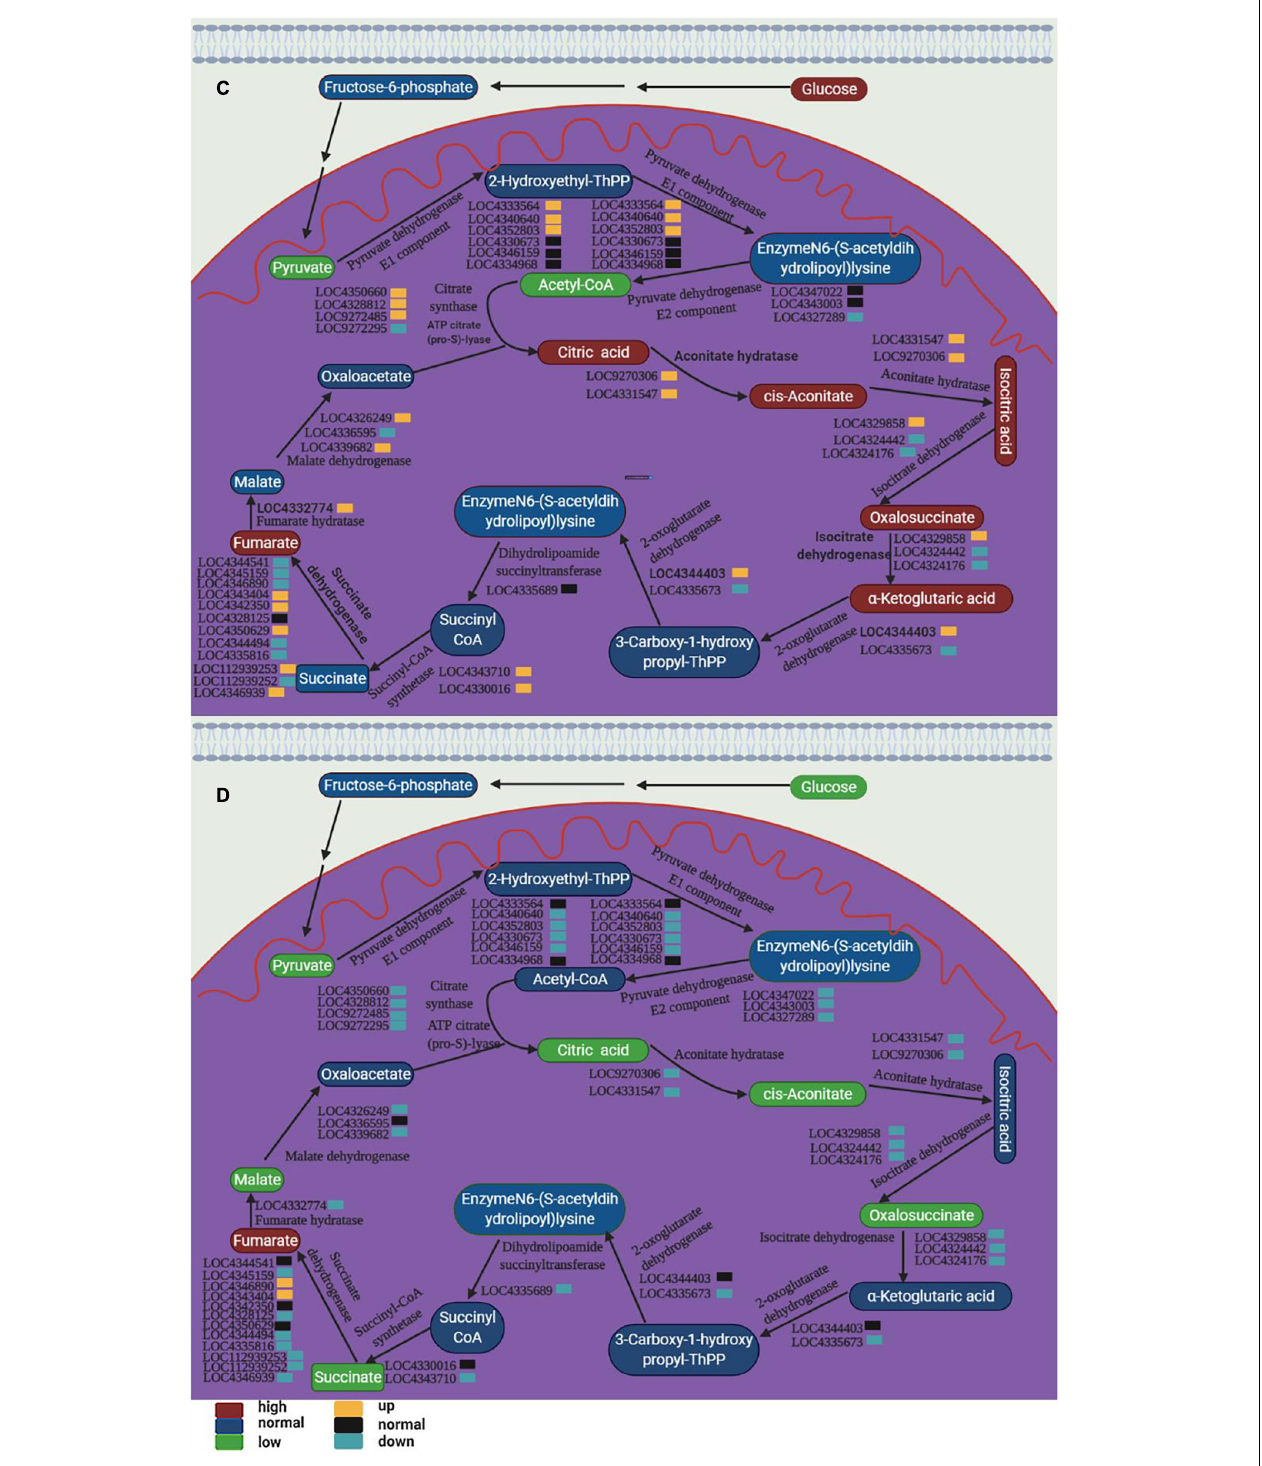
FIGURE 13 | TCA cycle pathways of two rice varieties. After spaceflight, the two rice varieties developed into TLP and TS respectively. TLP-DN3 (A) , TLP-DN6 (B) , TS-DN3 (C) , and TS-DN6 (D) show changes in the expression levels of metabolites and genes mapped to the TCA cycle pathway. The relative content of each metabolite in the grain is displayed in the form of a heat map from low (green) to high (red), as shown by the color scale. Enzymes related to these pathways are marked in red, and genes encoding enzymes are placed next to them. Similarly, gene expression levels are represented by yellow (up-regulated) and cyan (down-regulated). Blue and black, respectively, represent no significant changes in metabolites and gene expression.